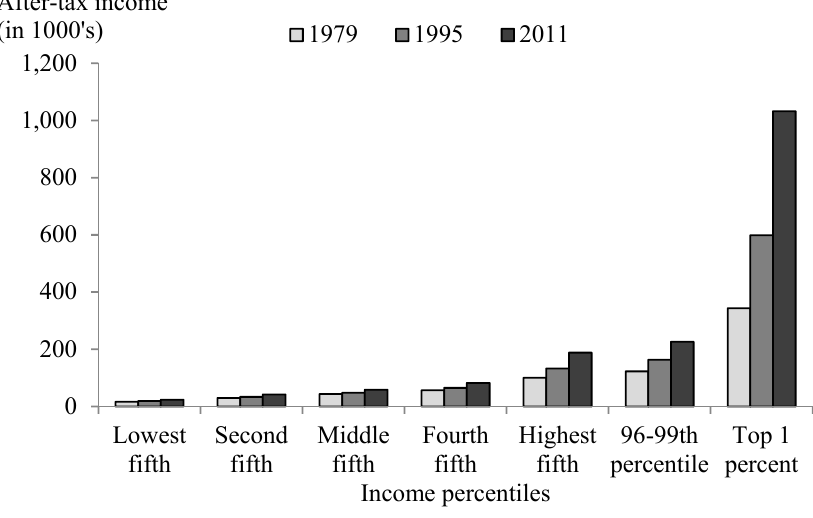
Figure 1. Growing Economic Inequality: After-Tax Household Income by Income Group, 1979–2011 (2011 Dollars). Source: (Congressional Budget Office 2014).